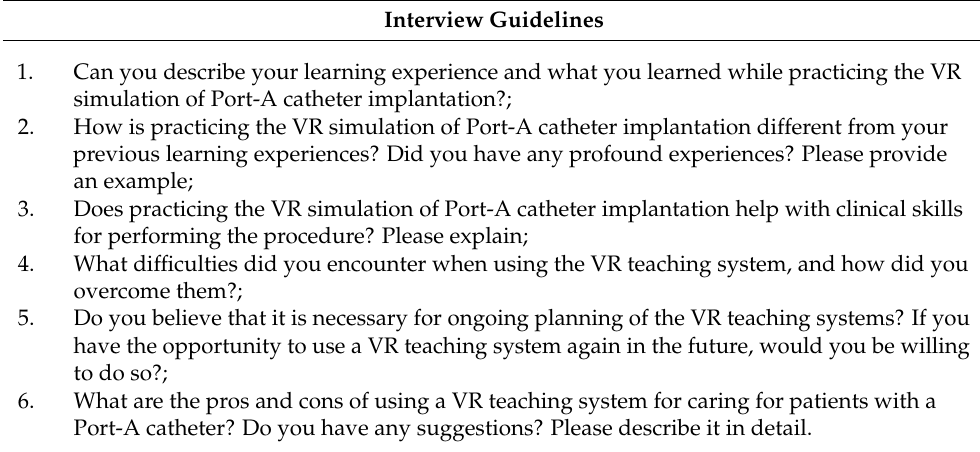
Table 4. Guidelines for virtual reality learning interviews on care for implantable Port-A